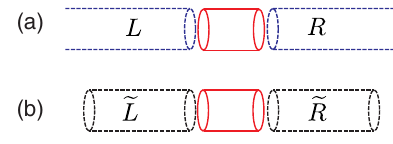
FIG. 7. (a) iDMRG – finite DMRG combined algorithm. (b) Finite DMRG algorithm.